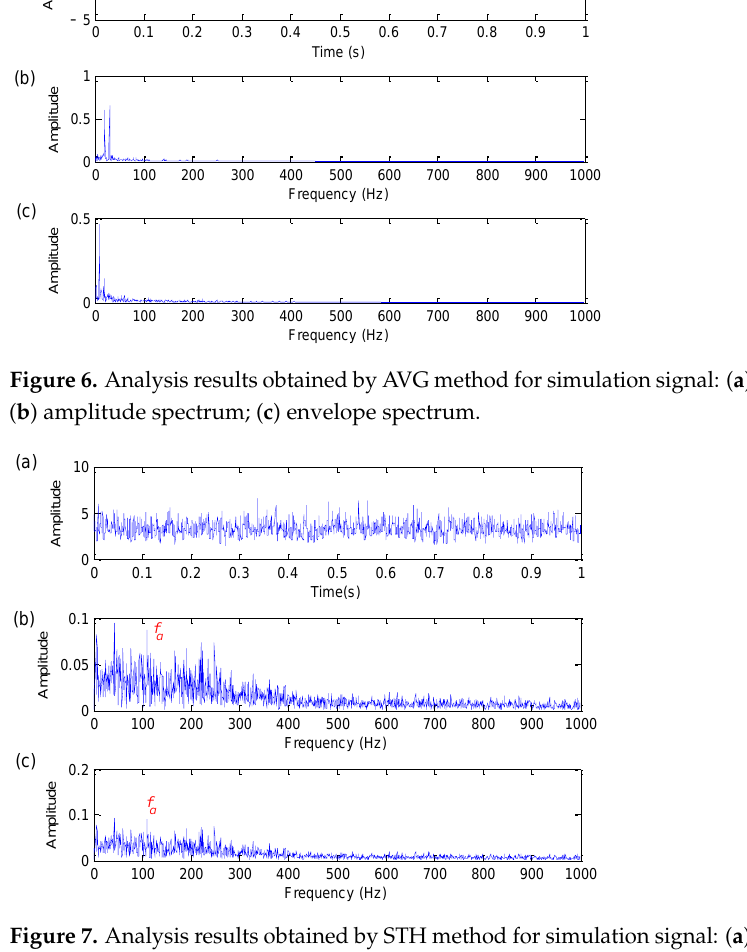
Figure 8. Analysis results obtained by EMDF method for simulation signal: ( a ) Time domain waveform; ( b ) amplitude spectrum; ( c ) envelope spectrum.